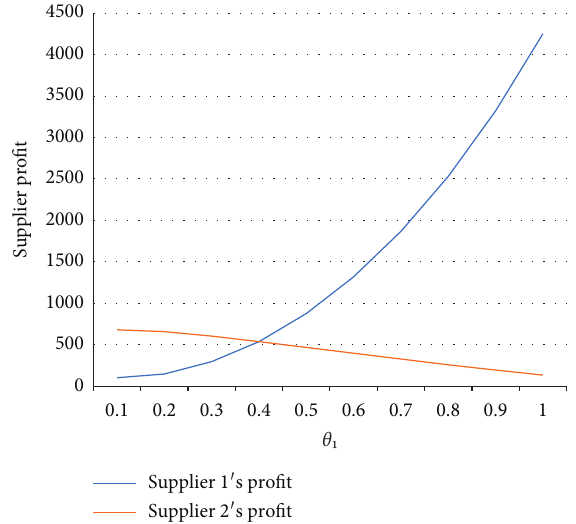
Figure 6: The impact of θ